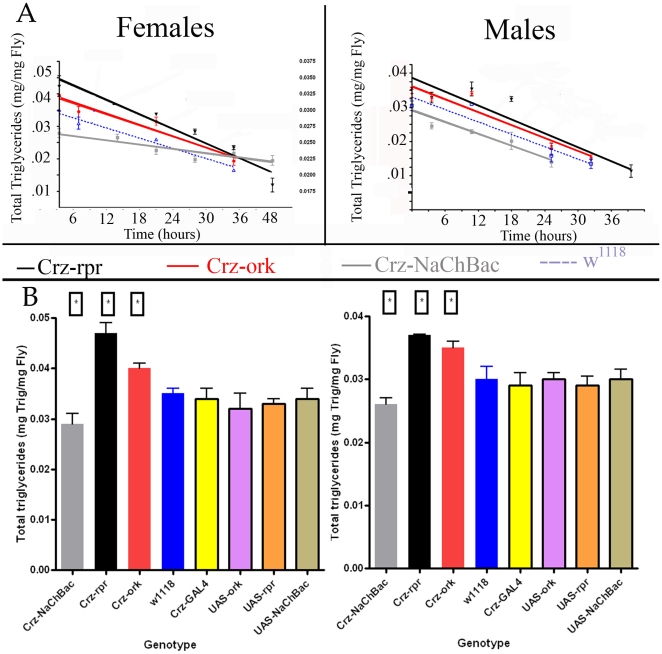
Triglyceride levels are altered in genotypes differing in corazonin neuronal function.
A. Total triglycerides were measured in animals with different corazonin neuronal function during starvation conditions. Three replicate vials of thirty animals per genotype were placed in vials containing 2% agar, collected at the designated times and triglycerides were measured. Values were normalized to weight and compared to standards. Note that prior to starvation, corazonin neuronal ablation results in higher triglyceride content. Additionally, the slopes of the regression lines are not different in males, whereas in females, the slopes significantly differ as determined by a Homogeneity of Slopes test. B. Triglyceride measurements from parental and experimental genotypes under normal rearing conditions. Data are means +/− SEM from three replicate experiments and asterisks indicate statistical significance (p<0.05) (ANOVA).